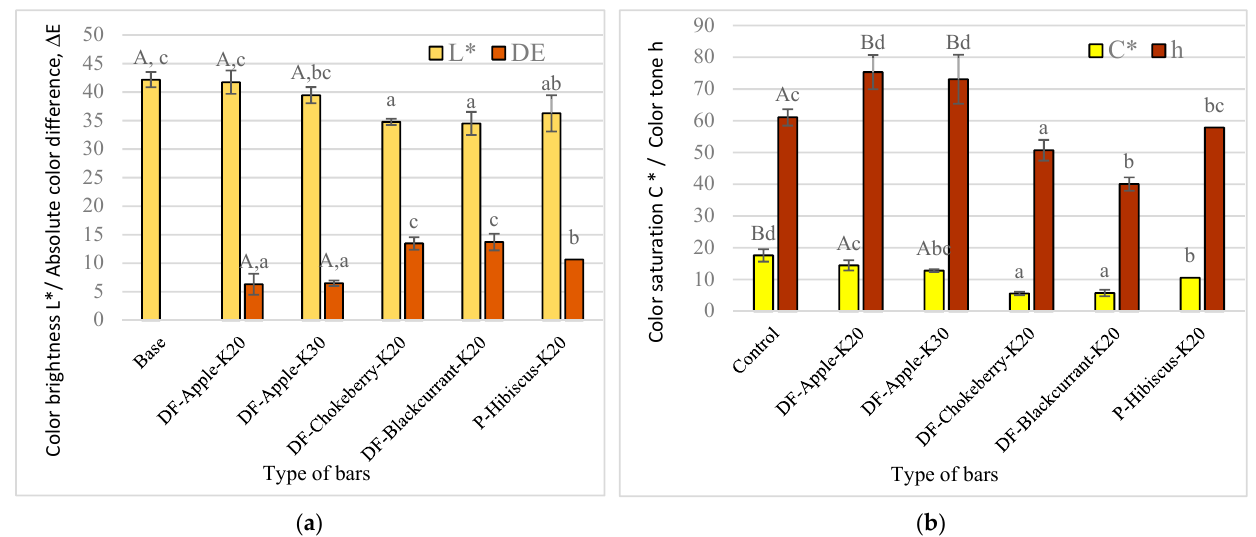
Figure 1. The influence of kale and fibre preparation addition on the colour parameters of multigrain bars: ( a ) Colour brightness L* and absolute colour difference Δ E, ( b ) colour saturation C* and colour tone h. Designation: a, b, c, d—homogeneous groups, the influence of: fibre preparations and A, B—kale at α = 0.05. The bar codes are explained in Table 4. Table 4. The recipe of multigrain bars based on the weight of all ingredients, with the addition of kale and fibre preparation or powder of dried hibiscus flower.